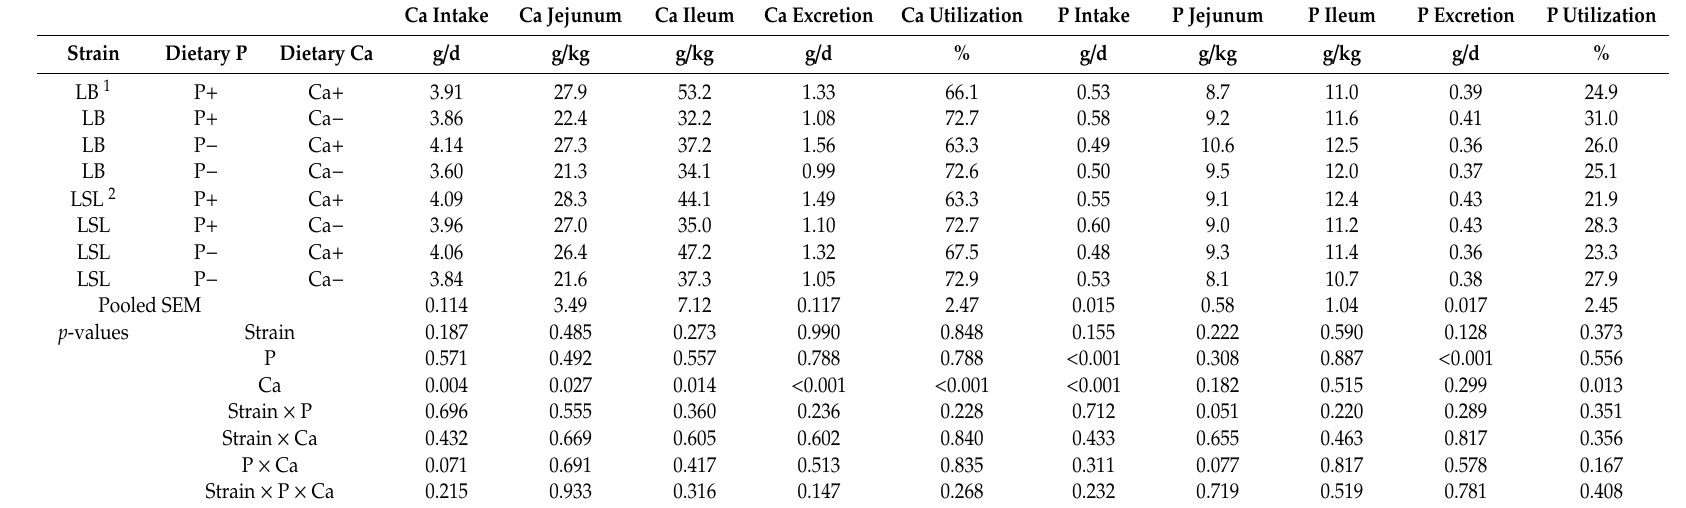
Table 7. E ff ect of strain, P, and Ca on Ca and P intake, concentration of Ca and P in the jejunum and ileum, and Ca and P utilization of laying hens at 31 weeks of